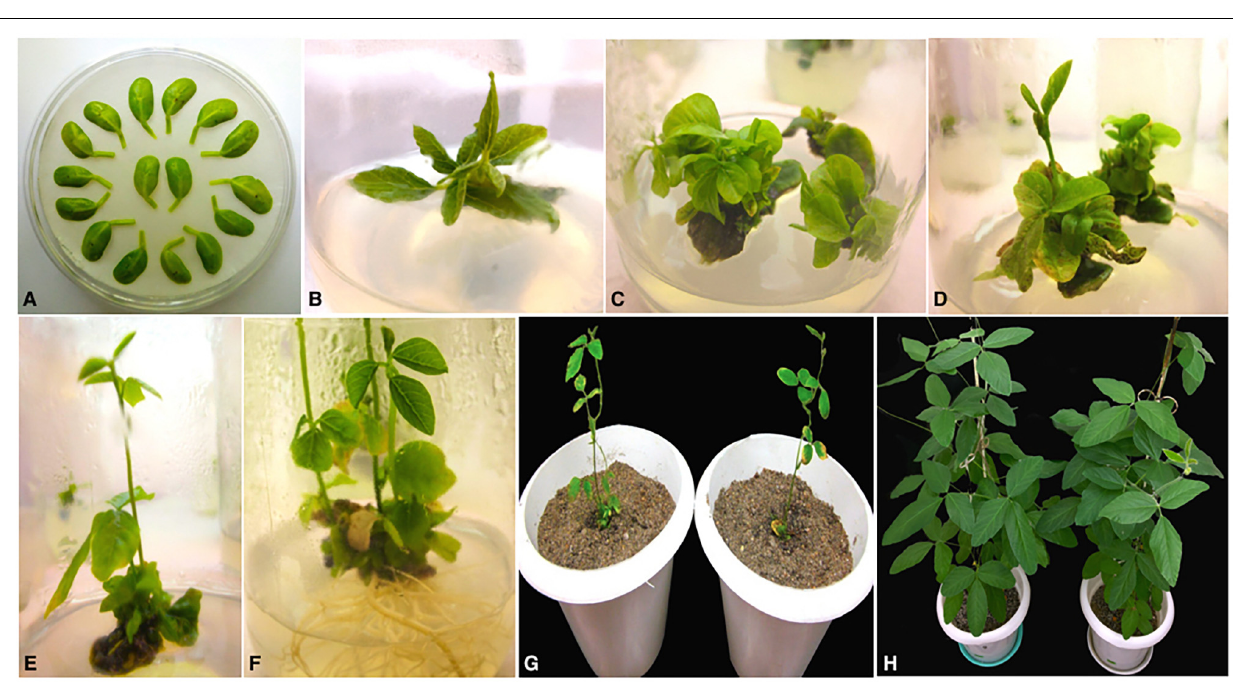
GGGTGTTTT-3 (cid:48) , q PEPCo R 5 (cid:48) -TTTTGCG